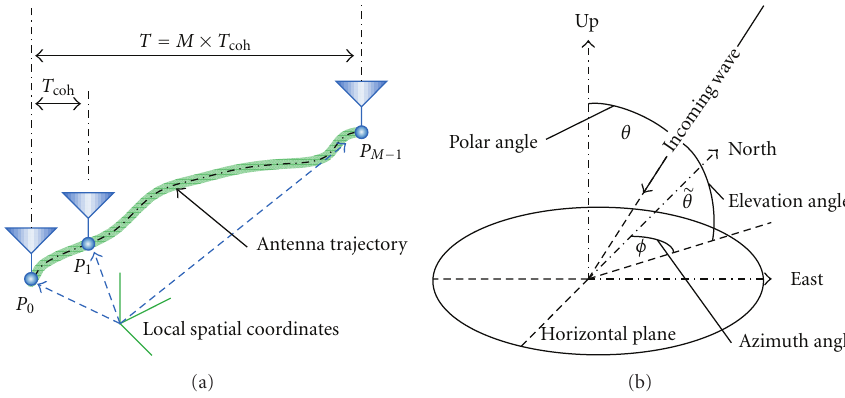
Figure 1: (a) Moving antenna trajectory during one signal snapshot. (b) Spatial coordinate